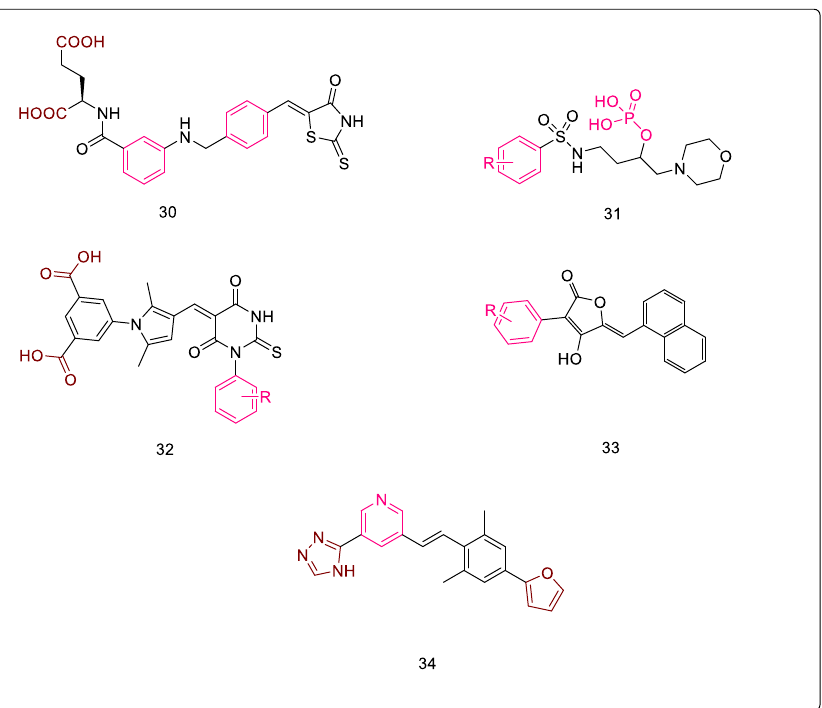
Figure 10. Structural scaffolds of some MurE inhibitors. ( 30 ) D-glutamate-based 5-benzylidenethiazolidin-4-one. ( 31 ) Phosphorylated hydroxyethylamines. ( 32 ) Benzene-1,3-dicarboxylic acids containing thioxoxdihydropyrimidinedione. ( 33 ) Naphthyl tetronic acid derivatives. ( 34 ) Furan- and triazole-containing stilbene derivatives.